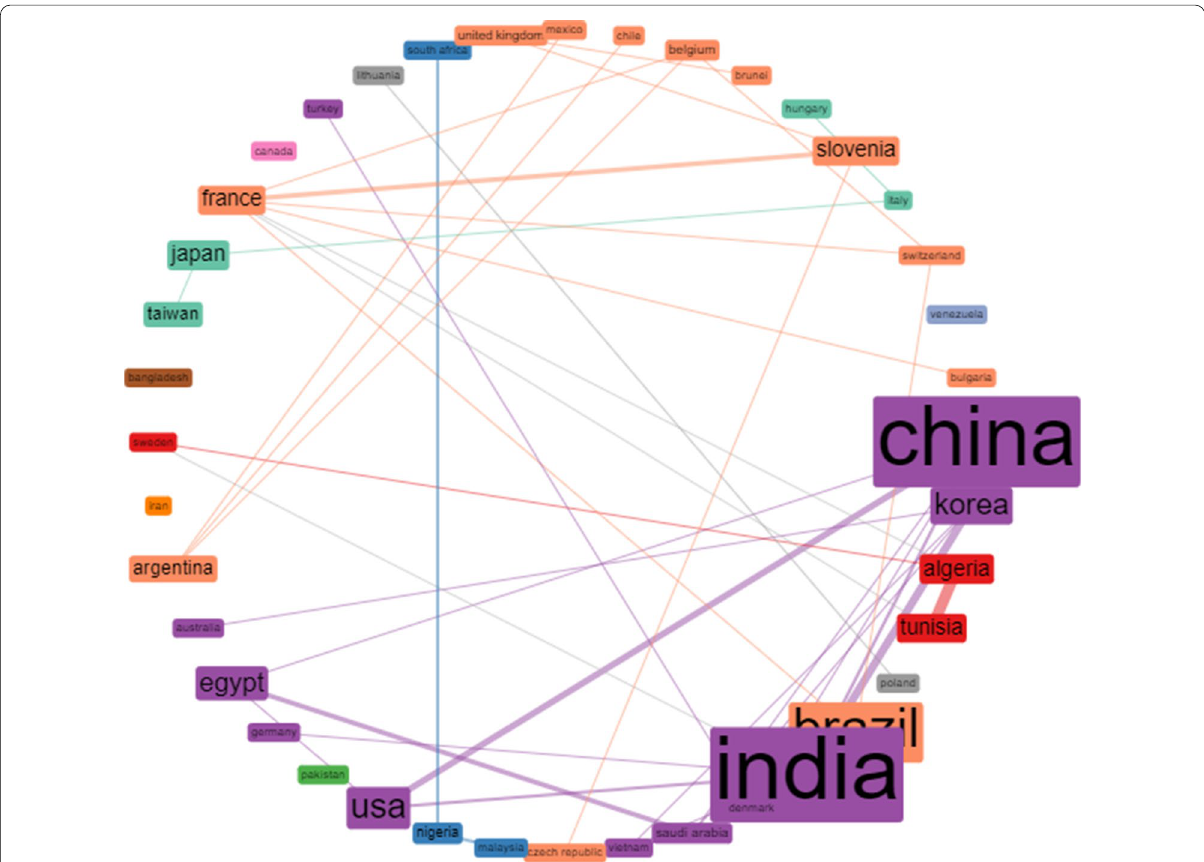
Fig. 3 Collaboration network of 40 top listed countries on keratinase research. The size of the node indicates the frequency of collaboration within countries, while the thickness of the network shows the strength of collaboration between